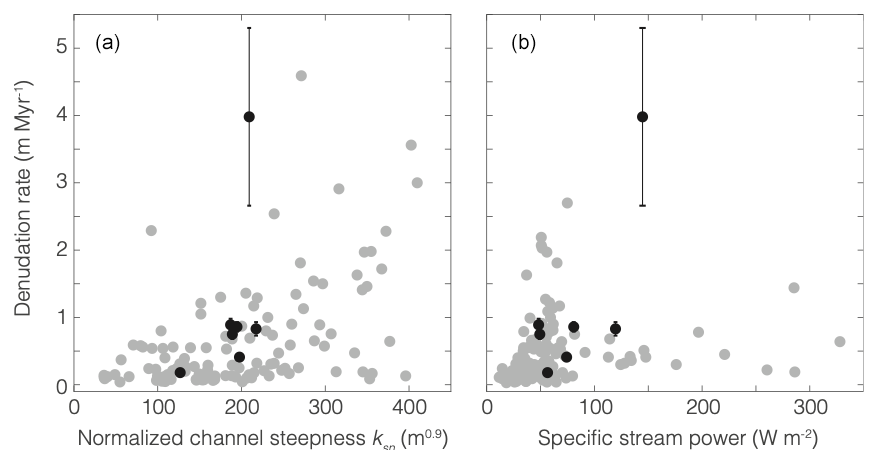
Figure 5. Basin-averaged denudation rates in the Himalaya versus normalized channel steepness (a) and specific stream power (b) . In both panels, black dots indicate our study sites in Far Western Nepal and gray dots indicate sites elsewhere in the Himalaya (Scherler et al., 2017, and Adams et al., 2016, in a ; Olen et al., 2016, in b ). To avoid introducing biases to comparisons of denudation rate estimates determined from different versions of the CRONUS calculator, the black dots in Fig. 5 show denudation rate estimates at our study sites that have been recalculated using the same version of the CRONUS calculator (v2.2) as that used in Adams et al. (2016), Olen et al. (2016), and Scherler et al. (2017). These rates are an average of 19% (range: 16%–26%) higher than those calculated with CRONUS v2.3 in Table